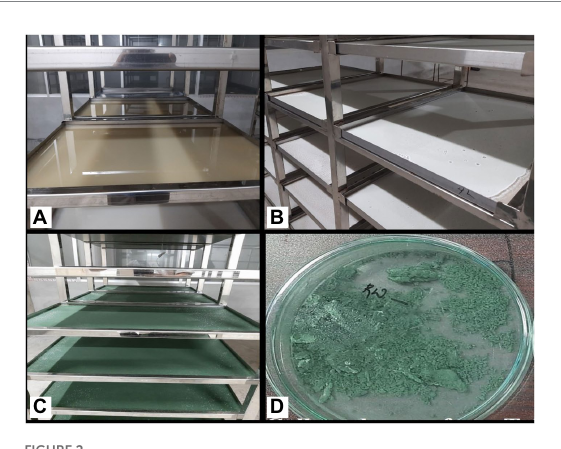
FIGURE 2 Sporulation of Trichoderma isolates on WA medium employing LAISS. (A) Media pouring, solidification, and spore suspension inoculation. (B) Visual growth of white mycelia (C) Spore growth appears as a green layer. (D) Collected